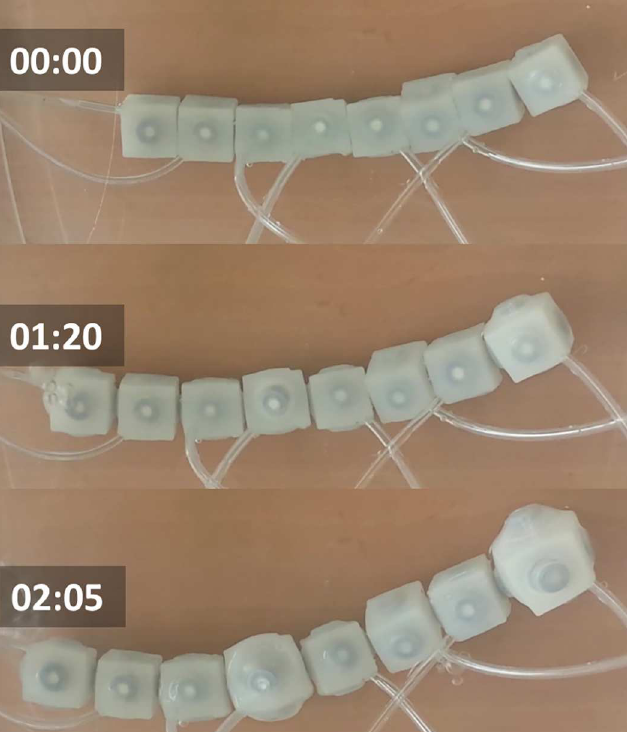
Fig 9. Cell Epiboly. Underwater experiments with a row of eight soft modules.The sequenceof images displaysa behavior that resembles the cellularbehavior of epiboly. Initiallymodulesare not pressurized. At t = 1s modulesare pressurized resultingin 29% linear extensionof the array at t = 2.05s. Time stamps are in the format